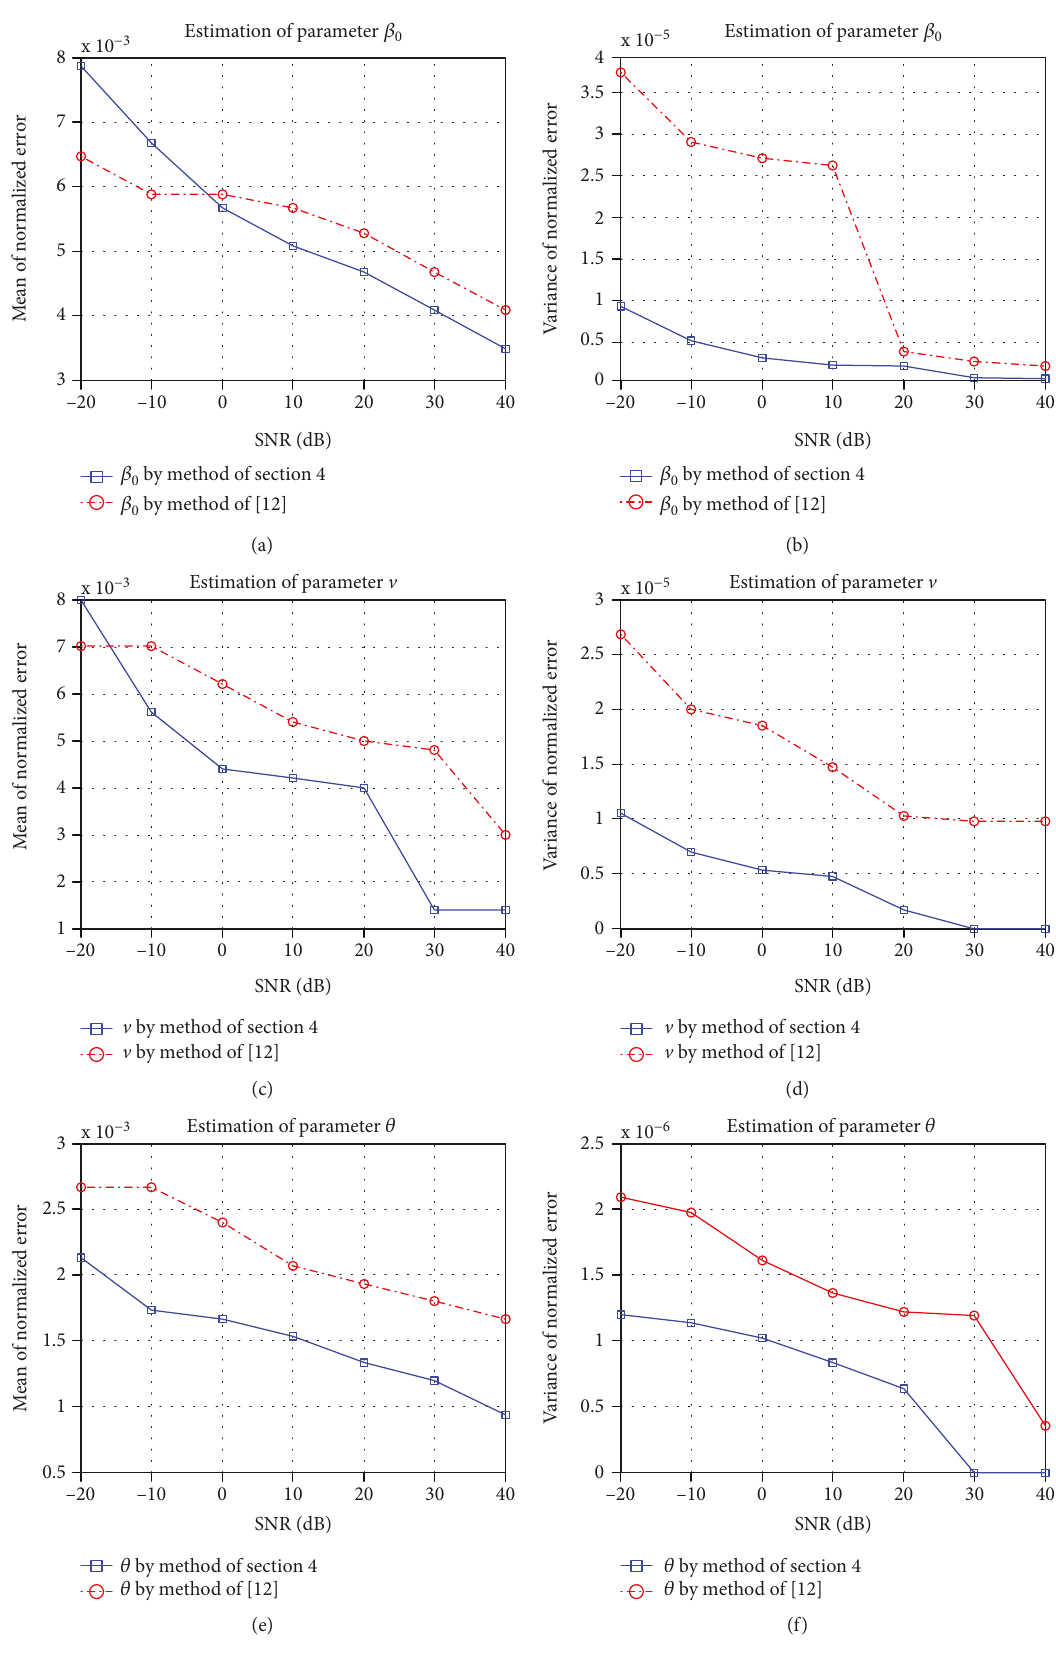
Figure 9: Mean value of the normalized error of (a) β